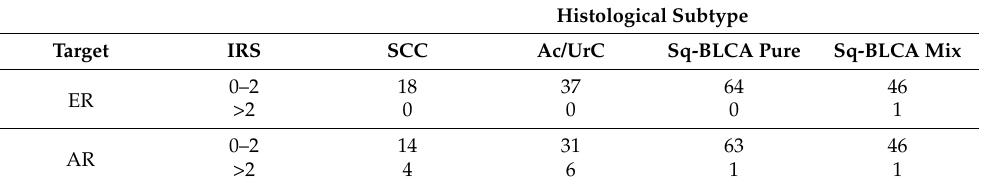
Table 3. Immunohistochemical results of hormone receptors in histological subtypes of bladder